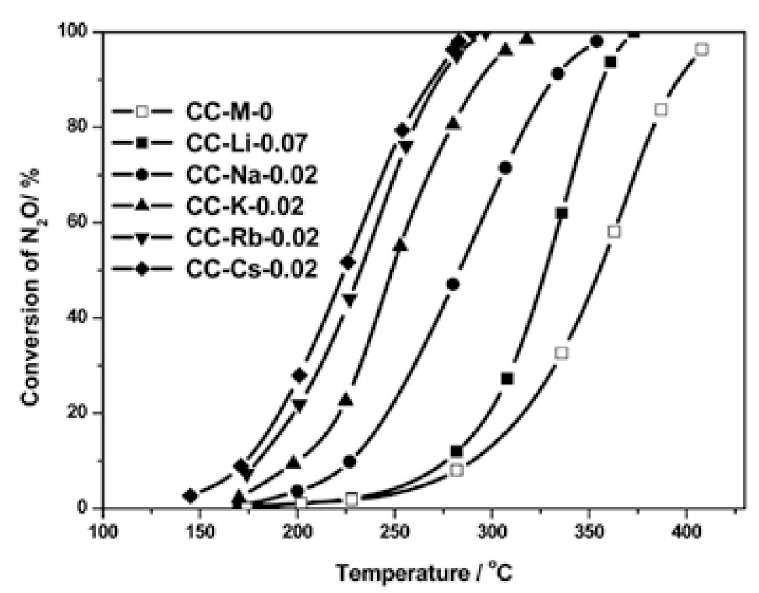
Figure 4. Different alkali metals for N 2 O decomposition on cobalt-cerium composite oxide cata- lysts [41]. Copyright 2009, American Chemical Society.